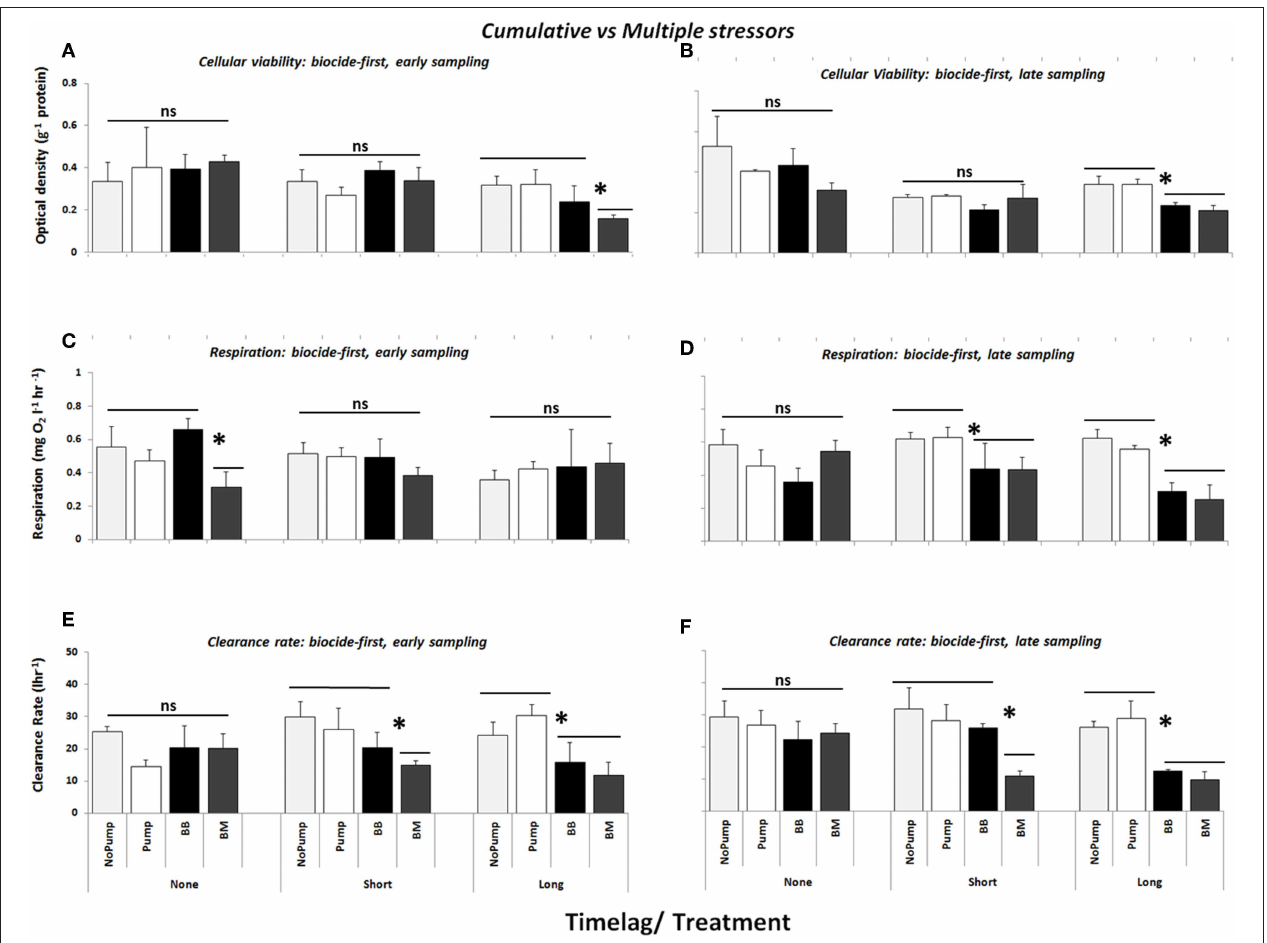
FIGURE 3 | Cellular viability (optical density g − 1 haemocyte protein), respiration (mg O 2 l − 1 hour − 1 ) and clearance rate (l/hour) of mussels/mussel assemblages at Malahide marina with biocide as the primary contaminant in cumulative (BB) and multiple stressor treatments (BM), M = Copper and B = Biocide. Also shown are the control treatments: “No Pump” (un-manipulated control) and “Pump” (procedural control). All stress treatments were delivered with three time-lag treatments (None, Short, and Long) between the arrival of the first stress event and the second stress event and were sampled directly after dosing (Early– A,C,E ) and 2 weeks after dosing (Late– B,D,F ) ( n = 3). Asterisks indicate significant differences between individual and/or groups of treatments.